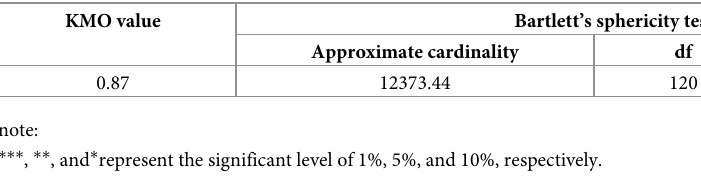
Table 2. Main components of land development intensity